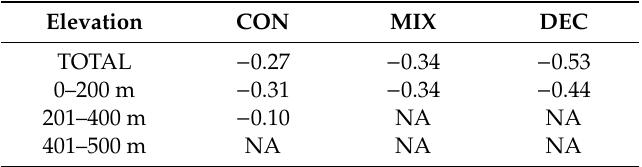
Table 3. Conditional density regarding human-induced land conversion a ff ecting EVIavg per elevation gradient. Considering di ff erences in elevation, the magnitude of the impact of human-induced land conversion on EVIavg is indicated 1 . Elevation CON MIX DEC TOTAL − 0.27 − 0.34 −